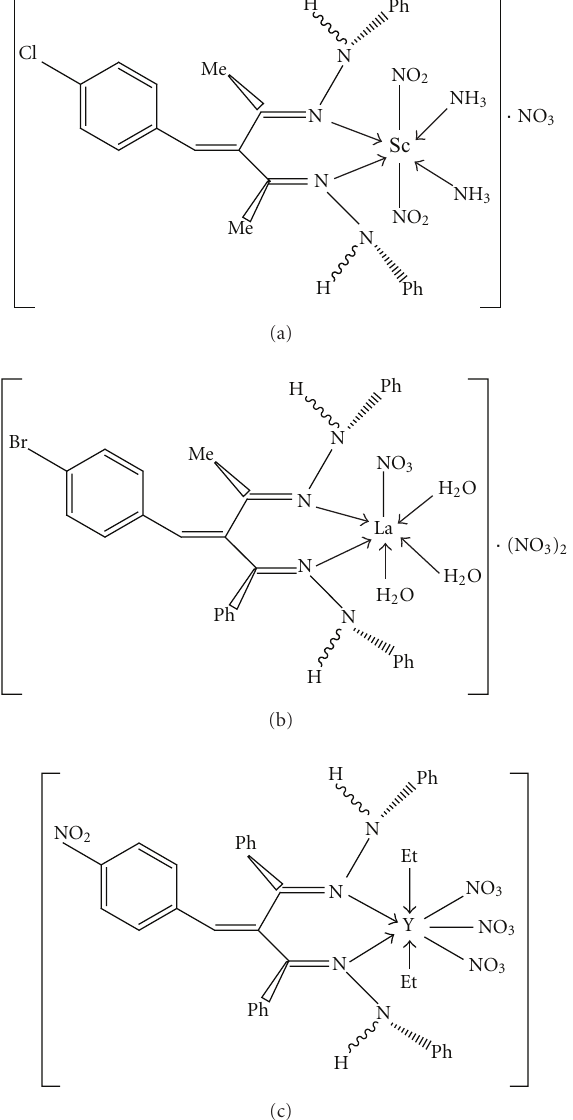
Figure 2: Representative structures of the